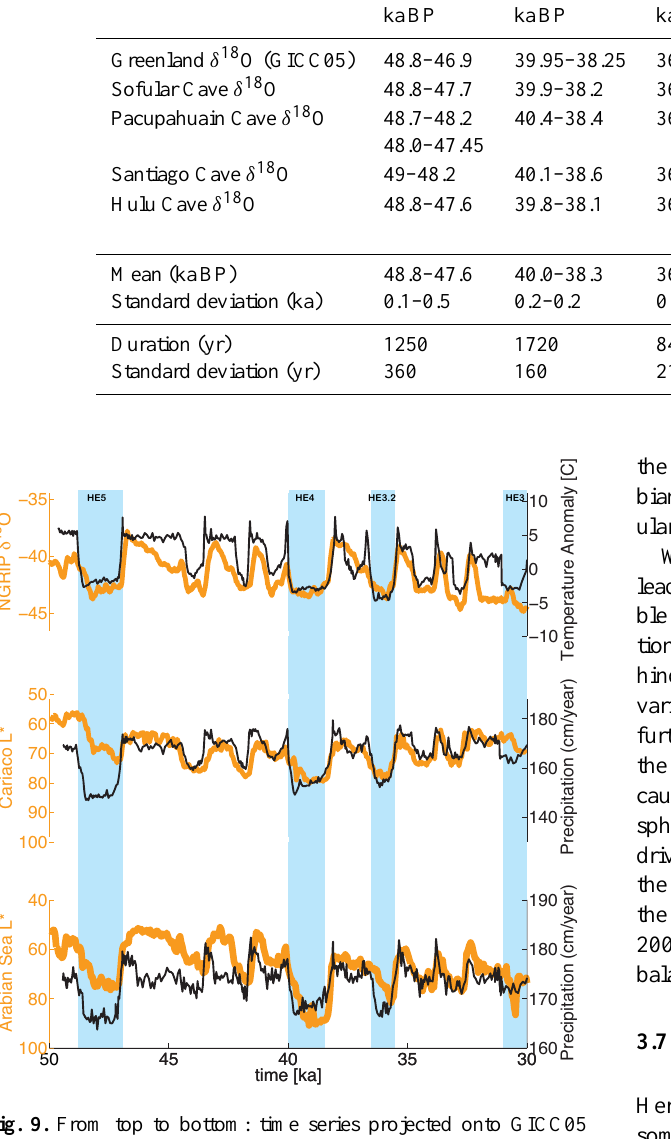
Fig. 9. From top to bottom: time series projected onto GICC05 age scale of simulated NE Greenland air temperature anomalies (40 ◦ W–10 ◦ E, 66–85 ◦ N) and NGRIP δ 18 O; simulated annual pre- cipitation anomalies over the Cariaco Basin (60–50 ◦ W, 5–20 ◦ N) compared to a reflectance record from the Cariaco Basin (Deplazes et al., 2013); time series of simulated Arabian Sea annual precipi- tation (45–65 ◦ E, 5–15 ◦ N) compared to a reflectance record ( L ∗ ) from the northeastern Arabian Sea (Deplazes et al., 2013). Model results are in black and paleoproxy records in